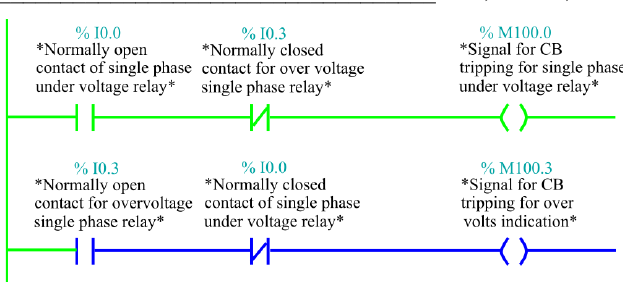
Fig. 7. PLC simulation for under-voltage fault for digital/analog relay at a single phase.